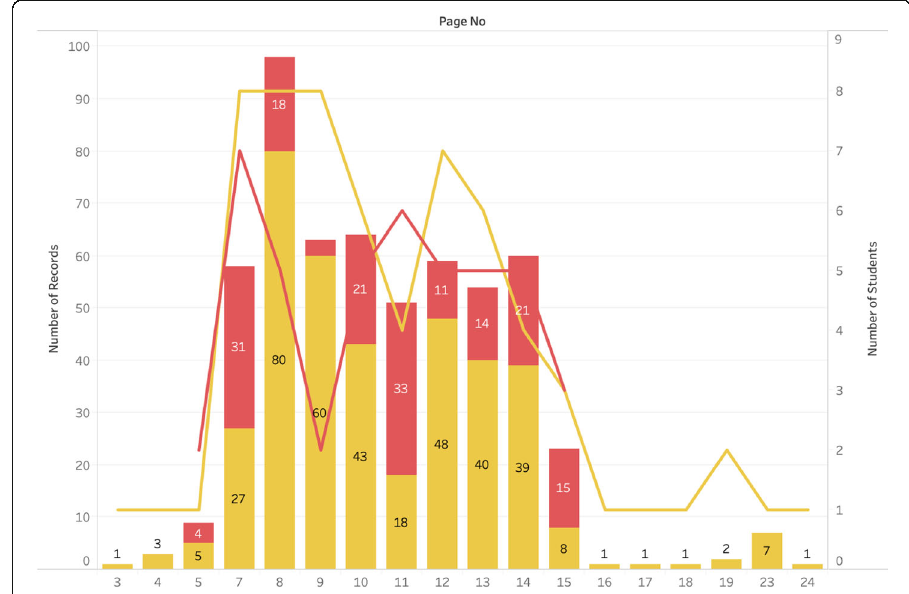
Fig. 6 Distribution of markers across the pages of the